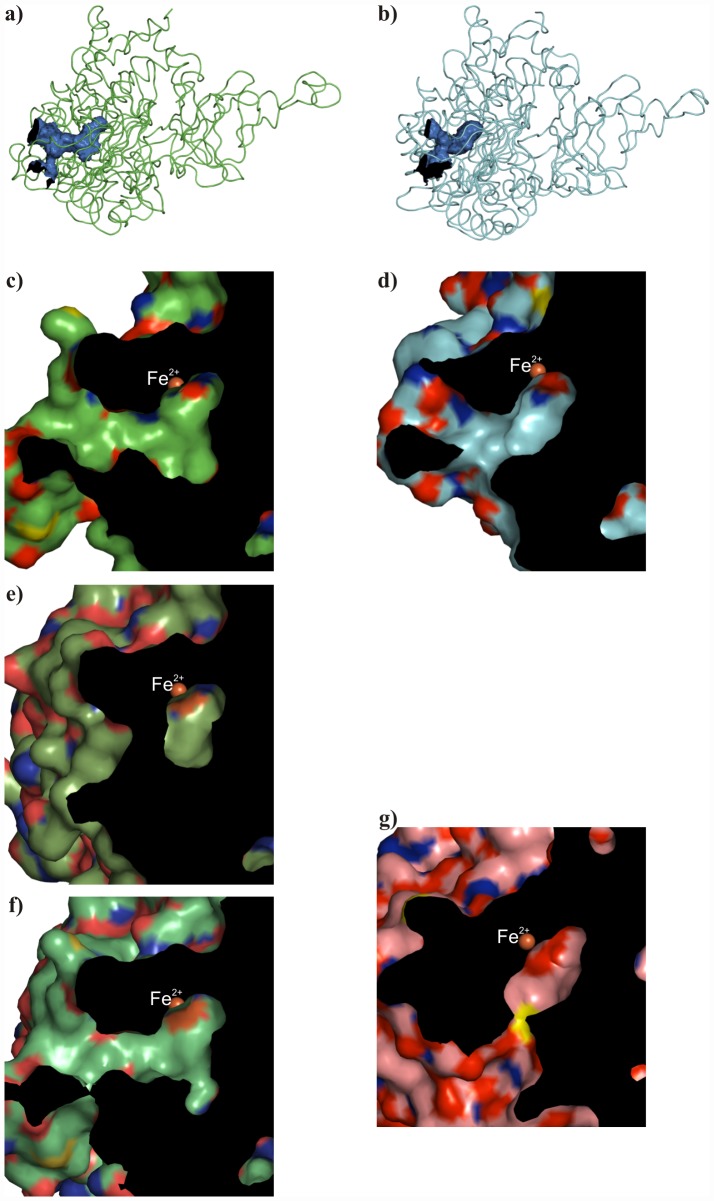
The positions and surface representations of the active site invaginations of BPDOB356, NDO9816-4, BPDORHA1, CumDOIP01, and NDO12038.a) Shows the overall active site cavity of BPDOB356 as determined by the program VOIDOO. b) The overall active site cavity of NDO9816-4 determined similar to a). The solvent accessible surface representations calculated by the program Pymol for c) BPDOB356, d) NDO9816-4, e) BPDORHA1, f) CumDOIP01, and g) NDO12038. BPDOB356 has a much larger active site cavity relative to BPDORHA1. The distal pocket of CumDOIP01 is less pronounced than that of BPDOB356. The view of the active site cavity of d) NDO9816-4 and g) NDO12038 has been rotated slightly relative to that of BPDOB356 in order to provide an unobstructed view of the entrance passageway.